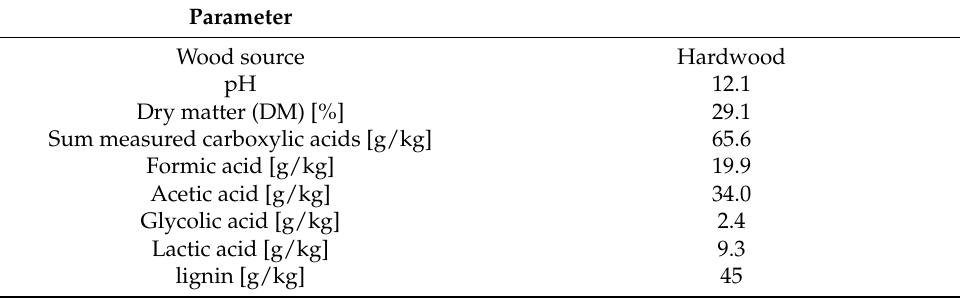
Table 1. Composition and characteristics of the pretreated BL